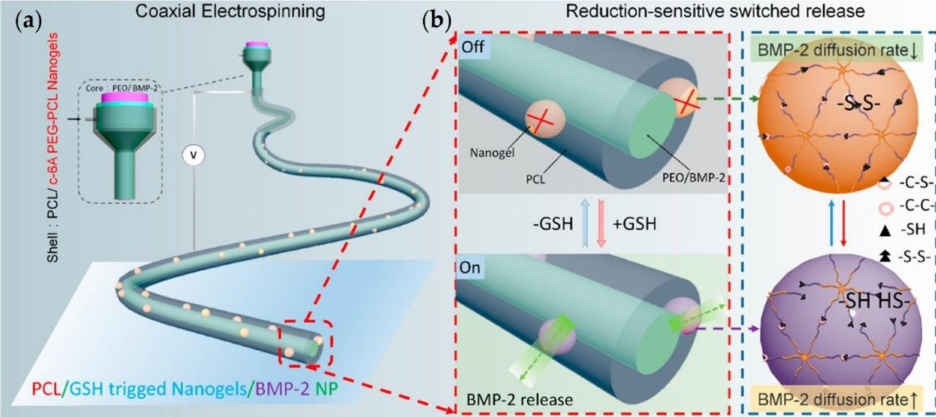
Figure 14. ( a ) Illustration of the fabrication of nanogel-in-nanofiber device with coaxial electro- spinning; ( b ) schematic representation of the redox-switched release with the nanogel. Reprinted from [17], with permission from American Chemical Society. Copyright © 2021, American Chemical